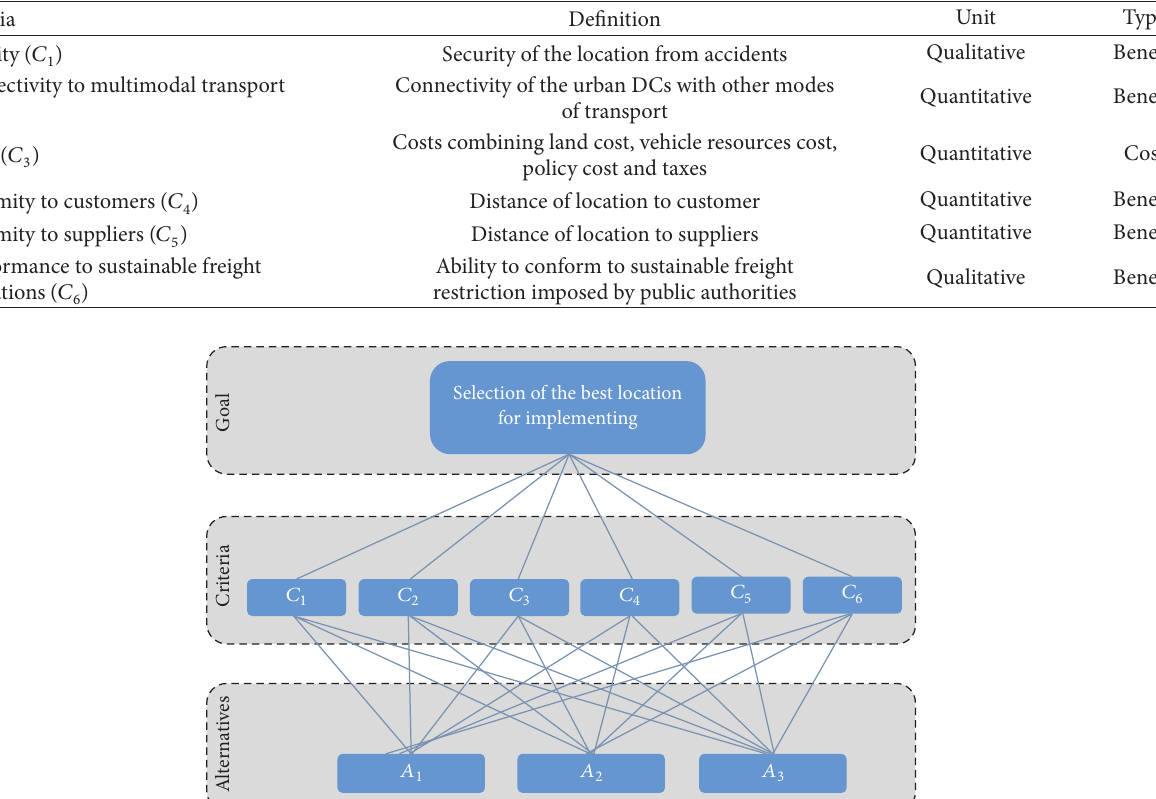
Table 3: The criteria used for selection of a location of DCs.